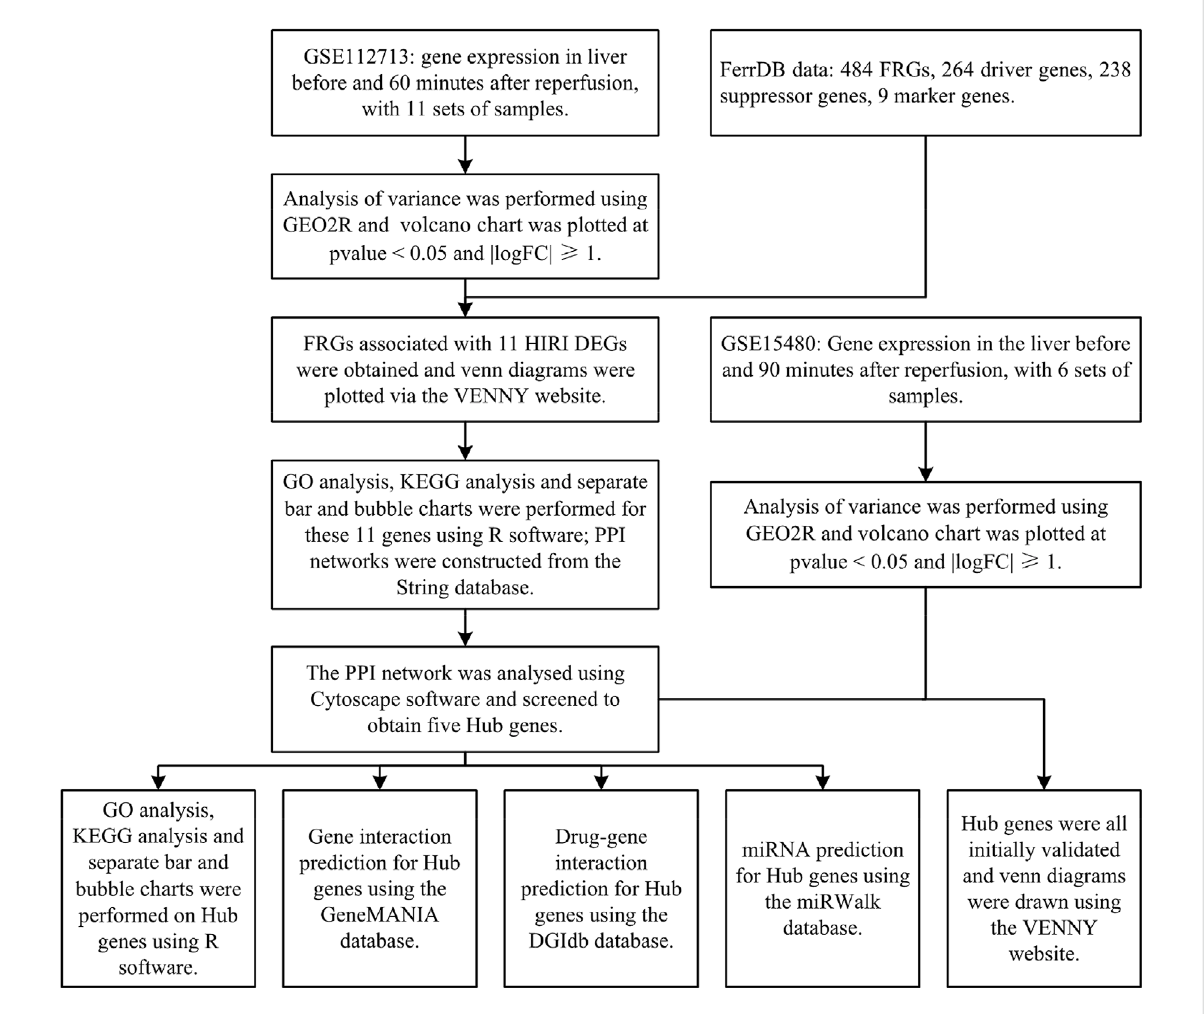
FIGURE 1 Technology roadmap: contains the overall design thinking for this